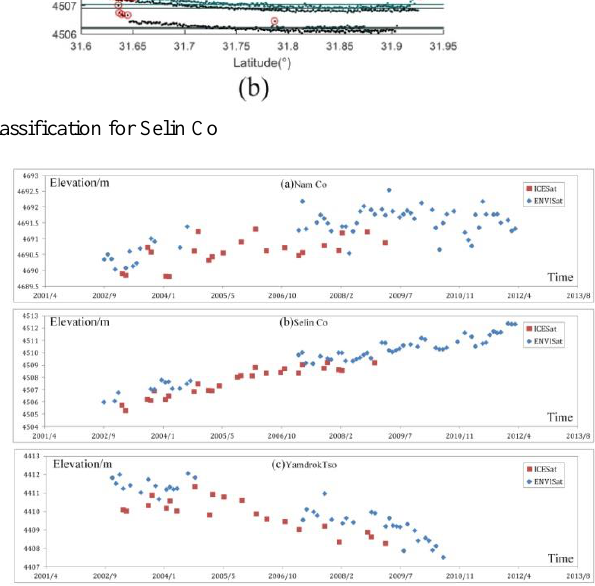
Figure 2. Typical lake water level sequences with the system errors (a) Nam Co; (b) Selin Co; (c)